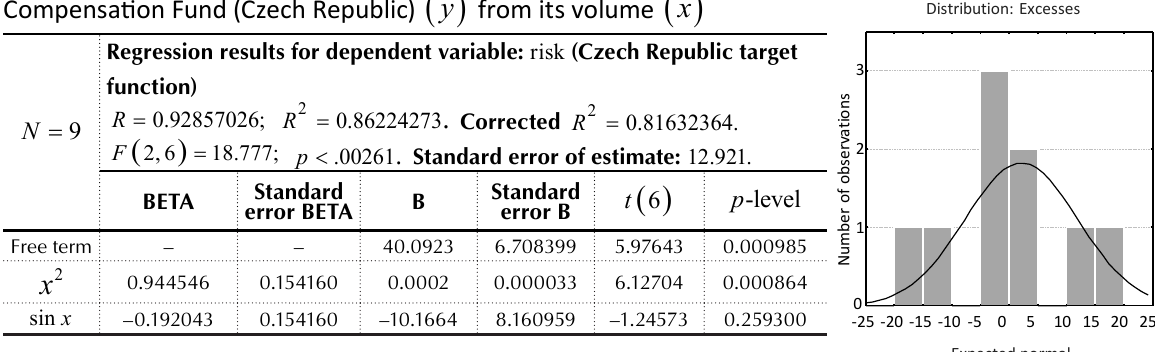
( ) y ( ) x from its volume